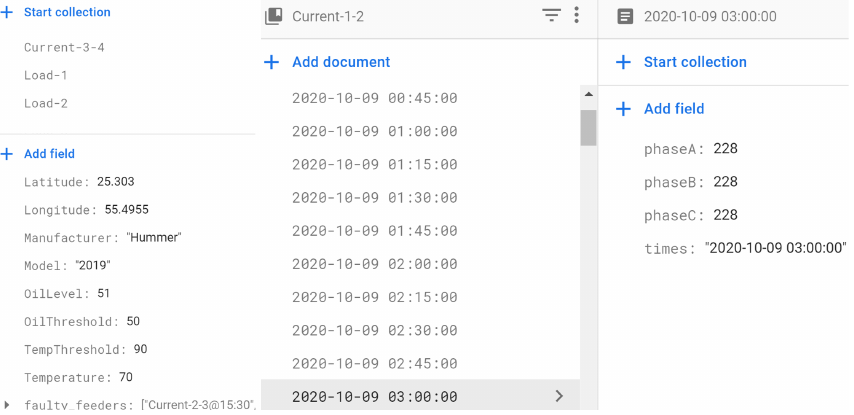
Figure 4. Transformer data available in cloud